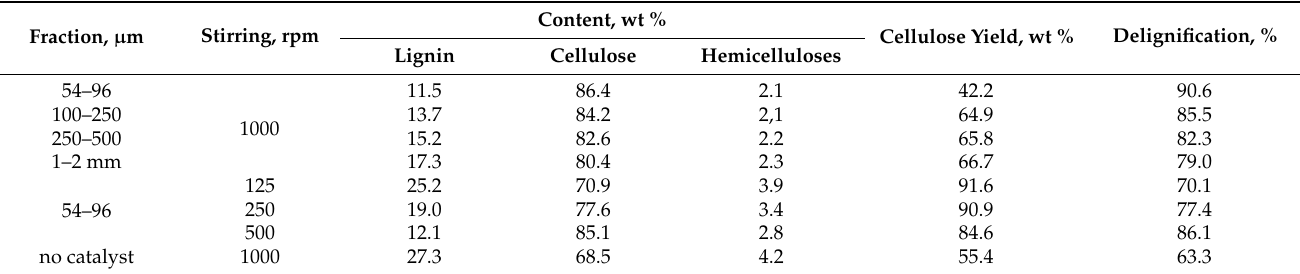
Table 9. Effect of the stirring rate and catalyst grain size on the solid product yield from the fractiona- tion of flax shives (10NiS450, 225 ◦